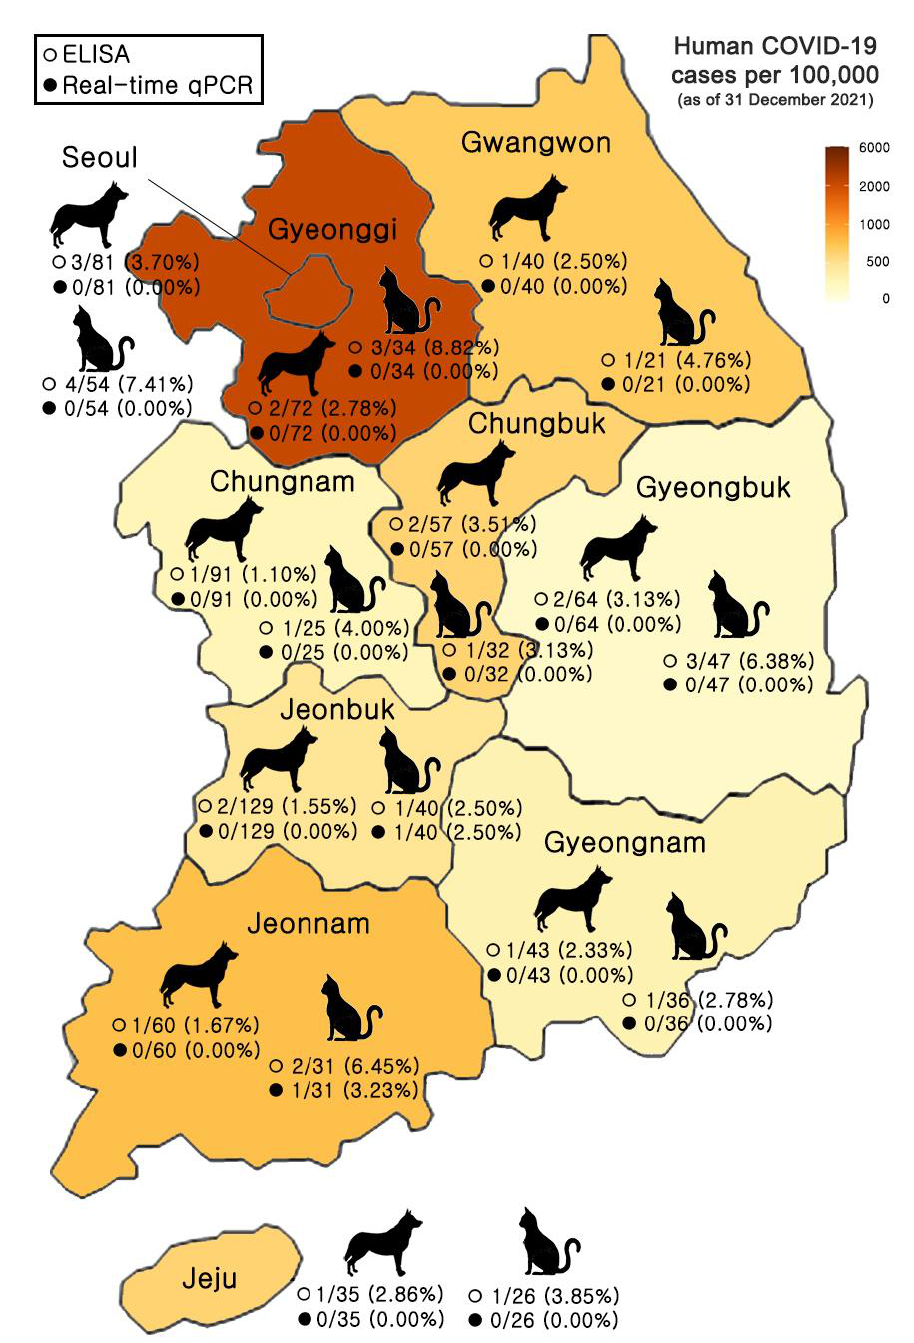
Figure 1. Distribution of dog and cat samples tested with real-time qPCR and ELISA across Korea. Data on human COVID-19 cases from the Ministry of Health and Welfare, 31 December 2021, and population data from the Ministry of the Interior and Safety, January 2020 .